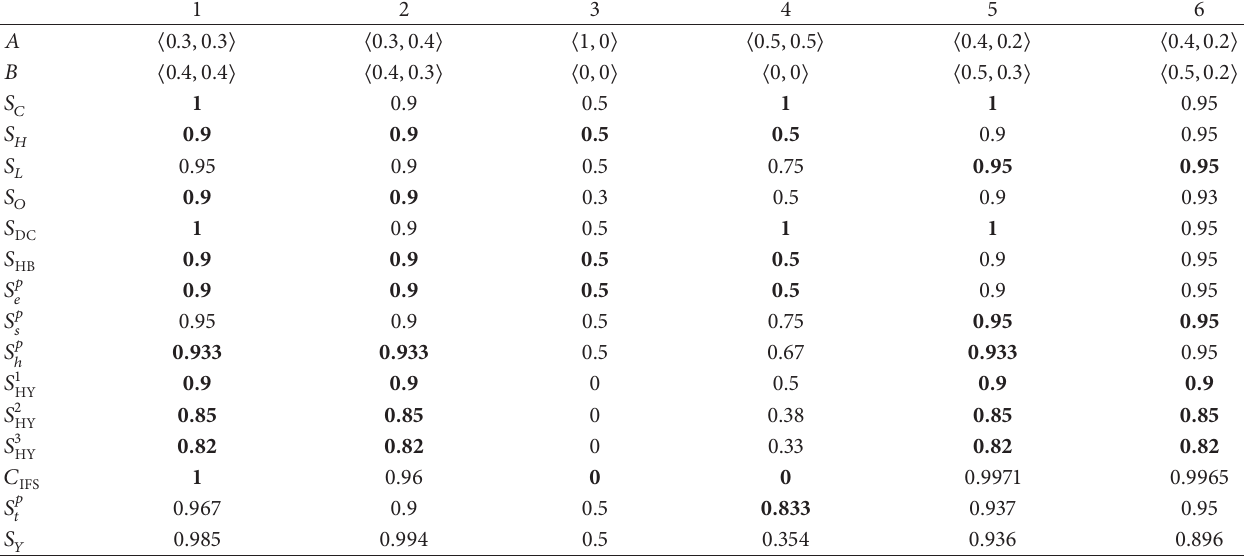
Table 1: The comparison of similarity measures (counterintuitive cases are in bold